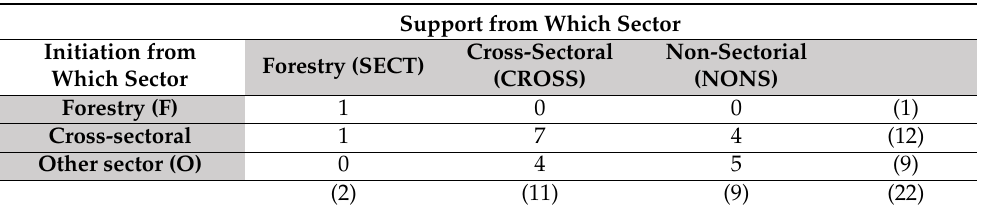
Table 3. Relations between sectoral initiation and sectoral support (remark: cases add up to 22 because two innovation cases received support from two different sectoral